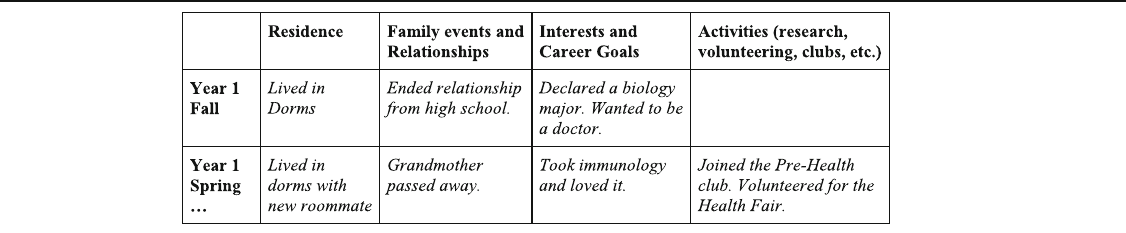
Table 1 Abbreviated biology life grid